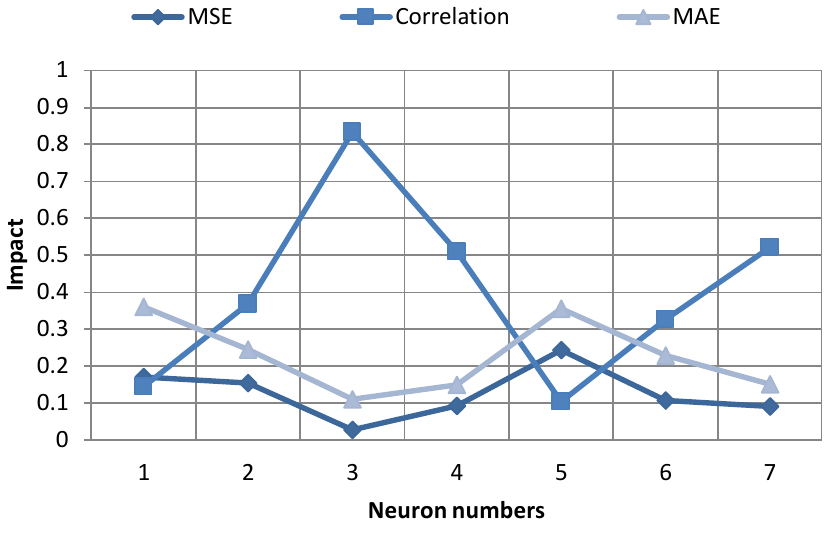
Figure 3. Influence of neuron numbers for training set.